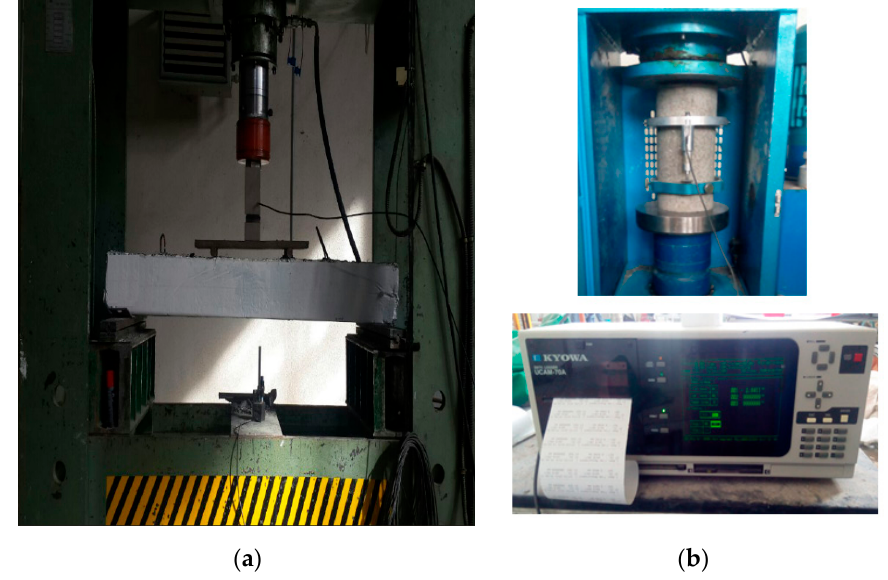
Figure 10. Test setup: ( a ) four-point bending test of the beams and the ( b ) compressive stress–strain setup.